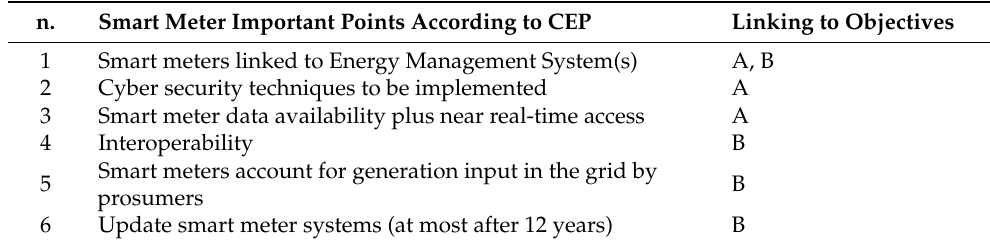
Table 11. Main points regarding smart metering applications as highlighted in the Clean Energy Package (CEP).